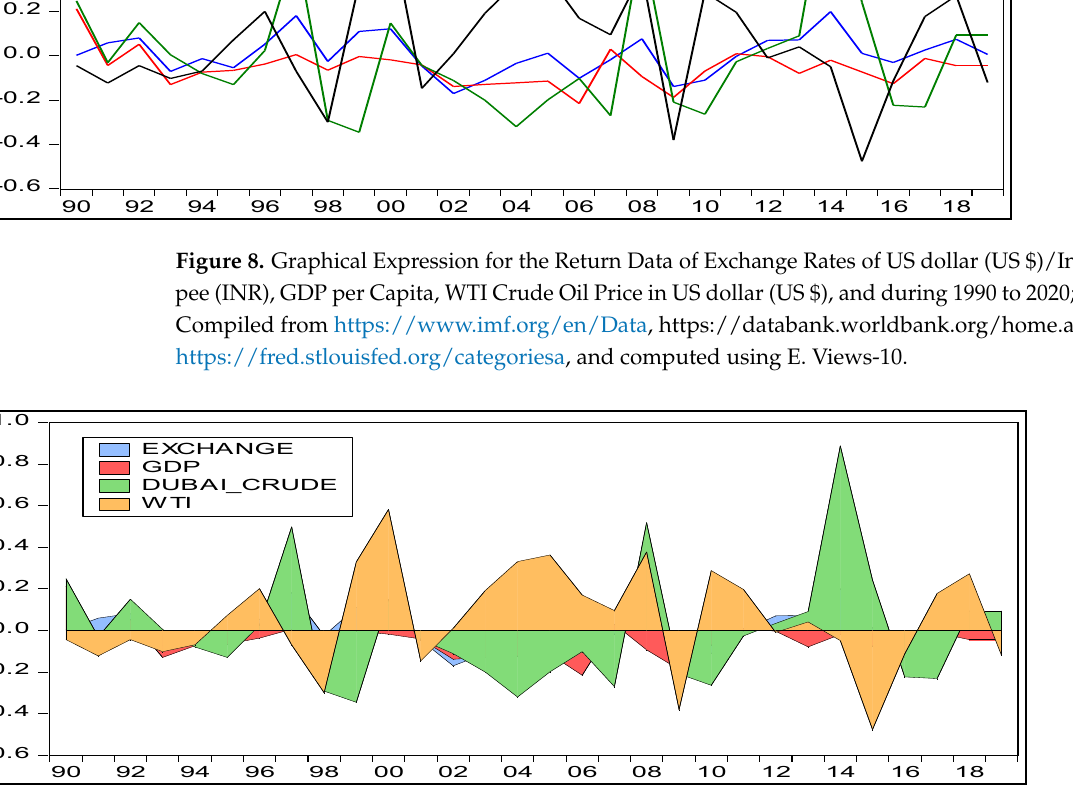
Figure 9. Graphical Expression for the Return Data of Exchange Rates of US dollar (US $)/Indian Rupee (INR), GDP per Capita, WTI Crude Oil Price in US dollar (US $), and during 1990 to 2020; Sources: Compiled from https://www.imf.org/en/Data, https://databank.worldbank.org/home.aspx, and https://fred.stlouisfed.org/categoriesa, and computed using E. Views-10.